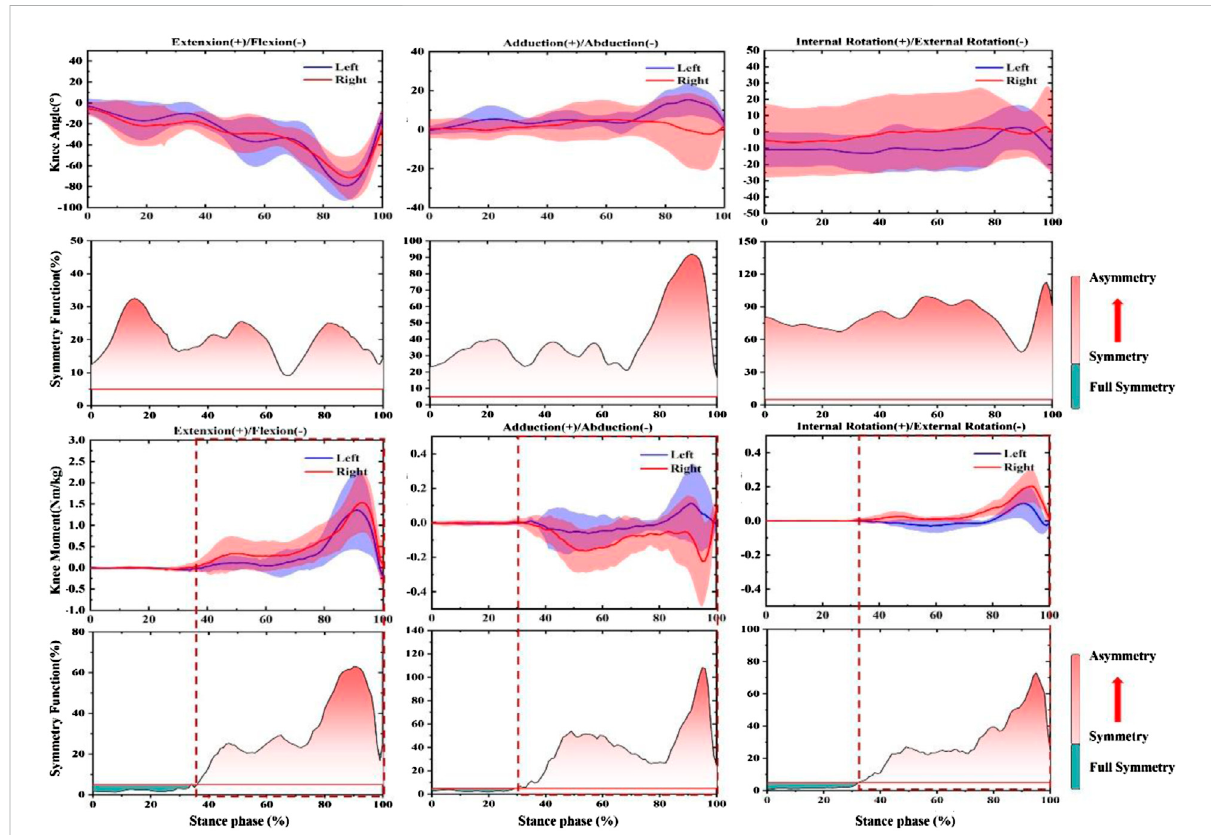
FIGURE 4 Illustration of SF degree in bilateral knee joint angle and moment during push-off phase after prolonged-running protocol for the CMJ test. Note: The red fi ll represents the degree of asymmetry, and the darker the color, the more asymmetry. The green fi ll represents full